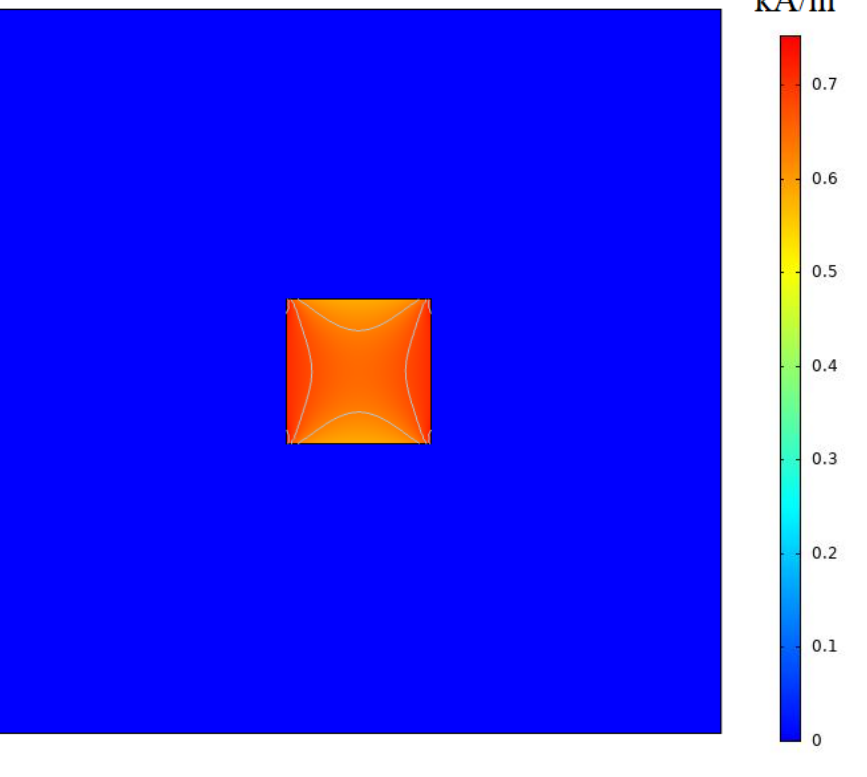
Figure 5. Magnetic field